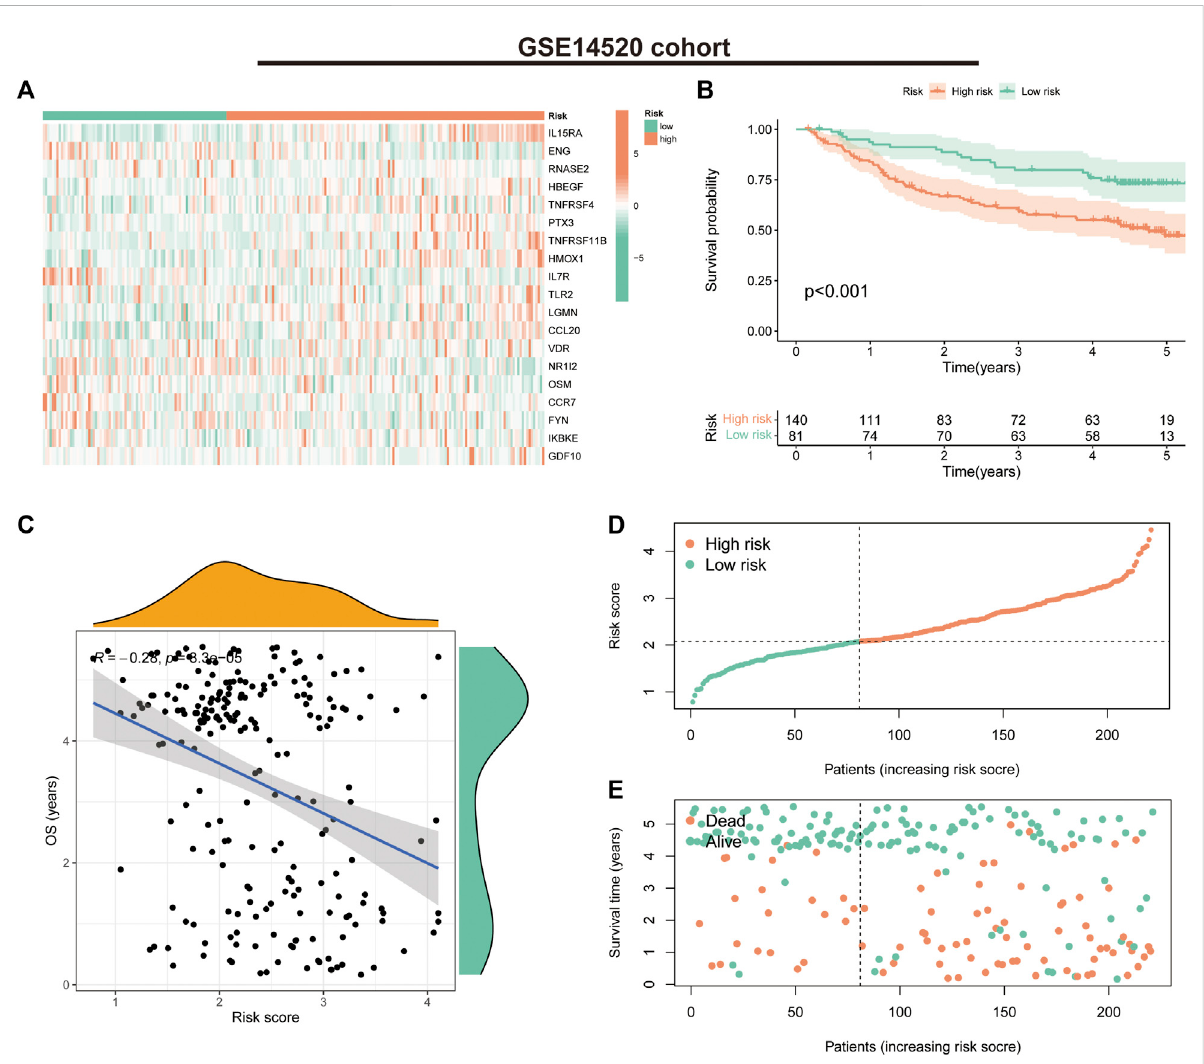
FIGURE 5 Prognostic values of the immune-related gene signature in the GSE14520 validation cohort. (A) Heat map showing expression levels of the 19 immune-related genes in the validation cohort. (B) Kaplan – Meier curve for overall survival (OS) in the validation cohort. (C) Scatter plot of correlation between risk score and OS in the validation cohort. (D) Risk score distribution in the validation cohort. (E) Survival time and status in the validation